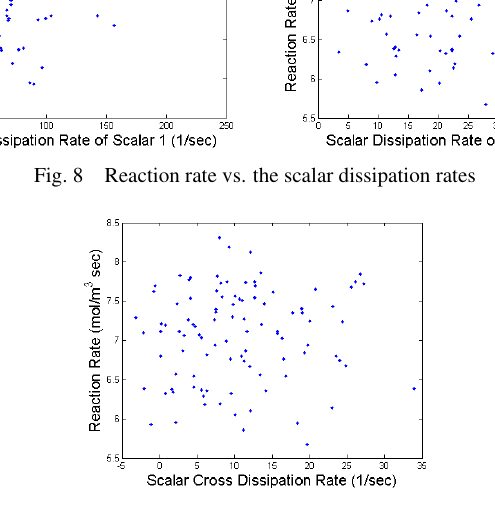
Fig. 9 Reaction rate vs. the scalar cross dissipation